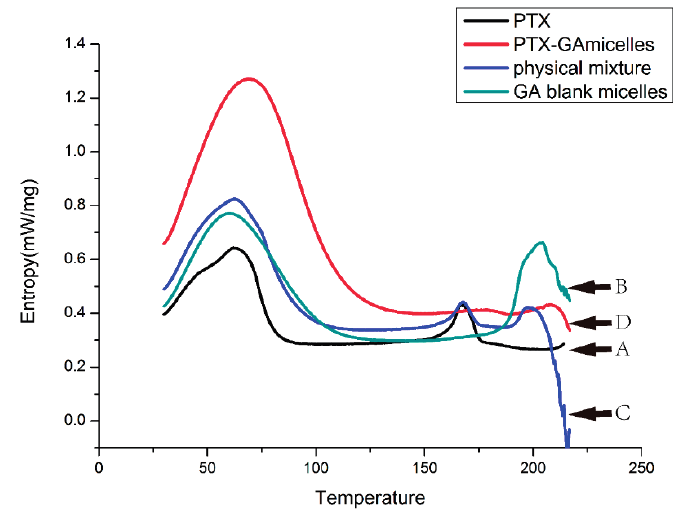
Figure 5. The DSC thermo gram of PTX powder (A), blank GA micelles freeze-dried powder (B), the physical mixture of PTX and blank GA micelles freeze-dried powder (C), and PTX-loaded GA micelles freeze-dried powder (D) from 0–220